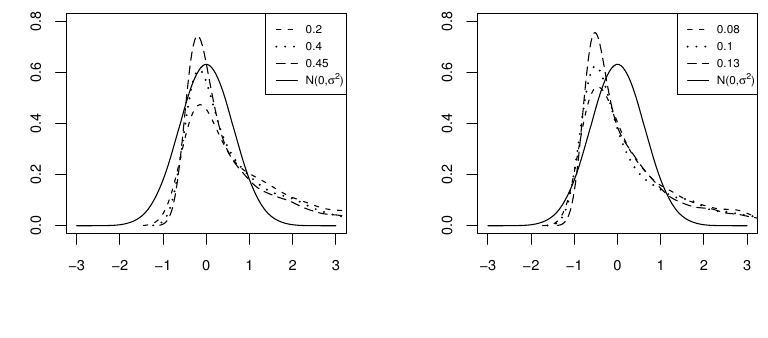
Figure 3. The true density under H 0 (solid line) and three kernel density estimators for the simulated statistic T n under H 0 for models M 2 (left plot) and M 4 (right plot) with n = 1000 and 1000 replications. Kernel is N (0 , 1) and σ 2 is such that in Theorem